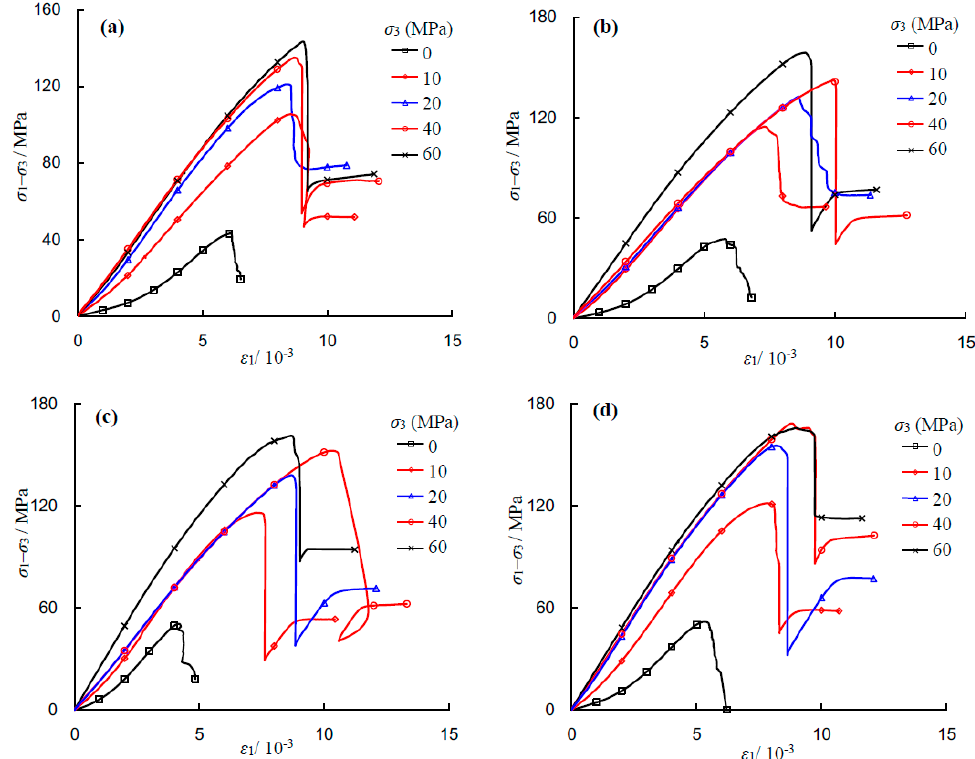
Figure 5. Stress–strain of saturated sandstone specimens under conventional triaxial compression. ( a ) Distilled water saturation; ( b ) 10% brine saturation; ( c ) 20% brine saturation; and ( d ) 30% brine saturation.